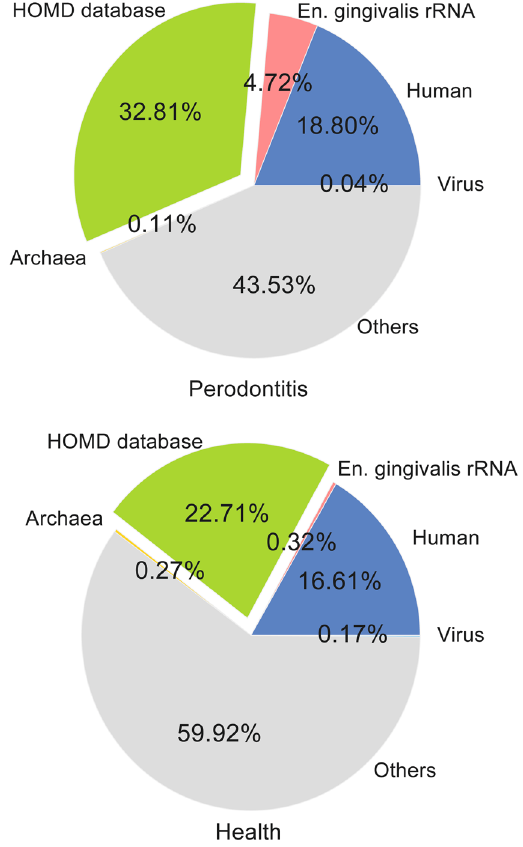
Figure 1. Mapping summary of periodontitis metatranscriptomes. The average proportion of cleaned putative mRNA reads mapped onto HOMD, En . gingivalis 18S rRNA (after rRNA removal using SortMeRNA), human reference genome (ver. GRCh38), virus genomes from NCBI database, archaea genomes from NCBI database. The upper panel shows the periodontitis, whereas lower one is the